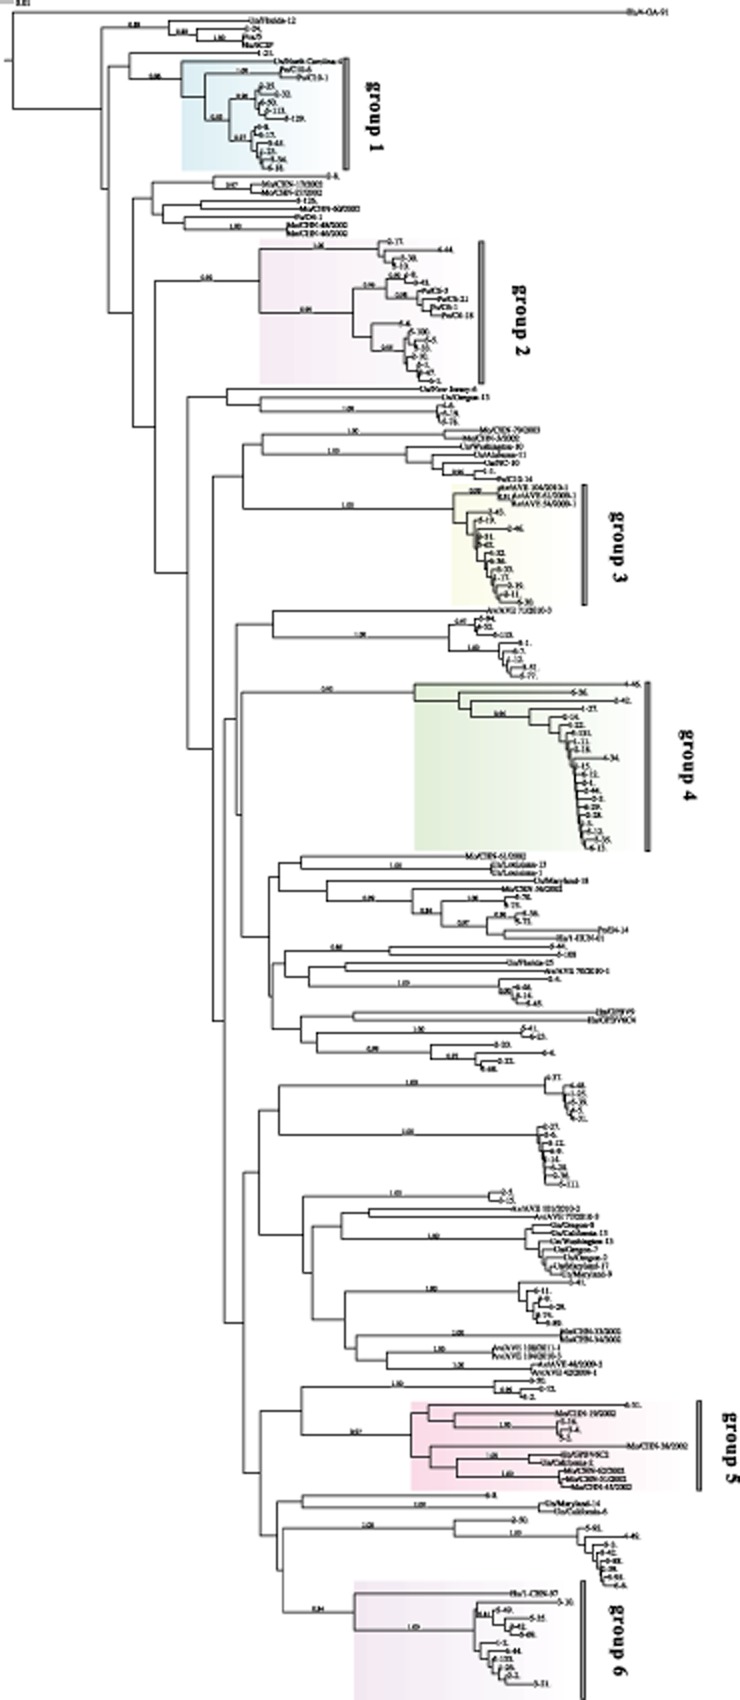
Neighbour-joining (Kimura 2-parameter model) phylogenetic tree of ∼ 200 bp segment 2 of the PBVs (genotype I) RNA-dependent RNA polymerase gene. A total of 204 sequences (139 sequences we obtained and 65 referenced sequences) were used to construct phylogenetic tree by mega 5.0. Six groups were displayed by different colours. A bootstrap value > 0.8 was indicated for the corresponding nodes, and the tree was statistically supported by bootstrapping with 1000 replicates. Bar, 0.01 substitutions per nucleotide.